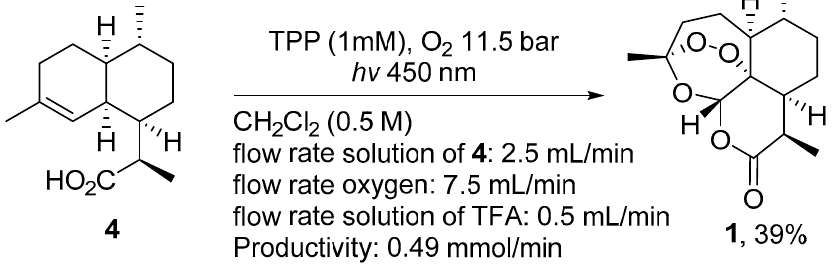
Scheme 15. Reaction conditions for continuous flow synthesis of artemisinin.